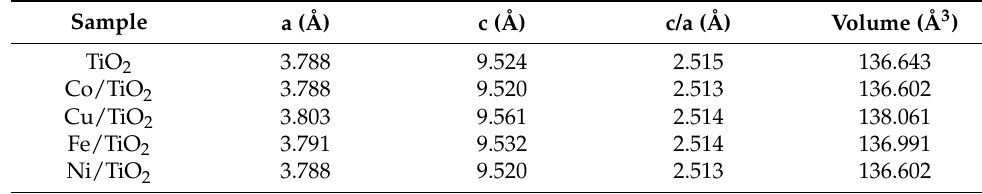
Table 2. Unit cell parameters for the